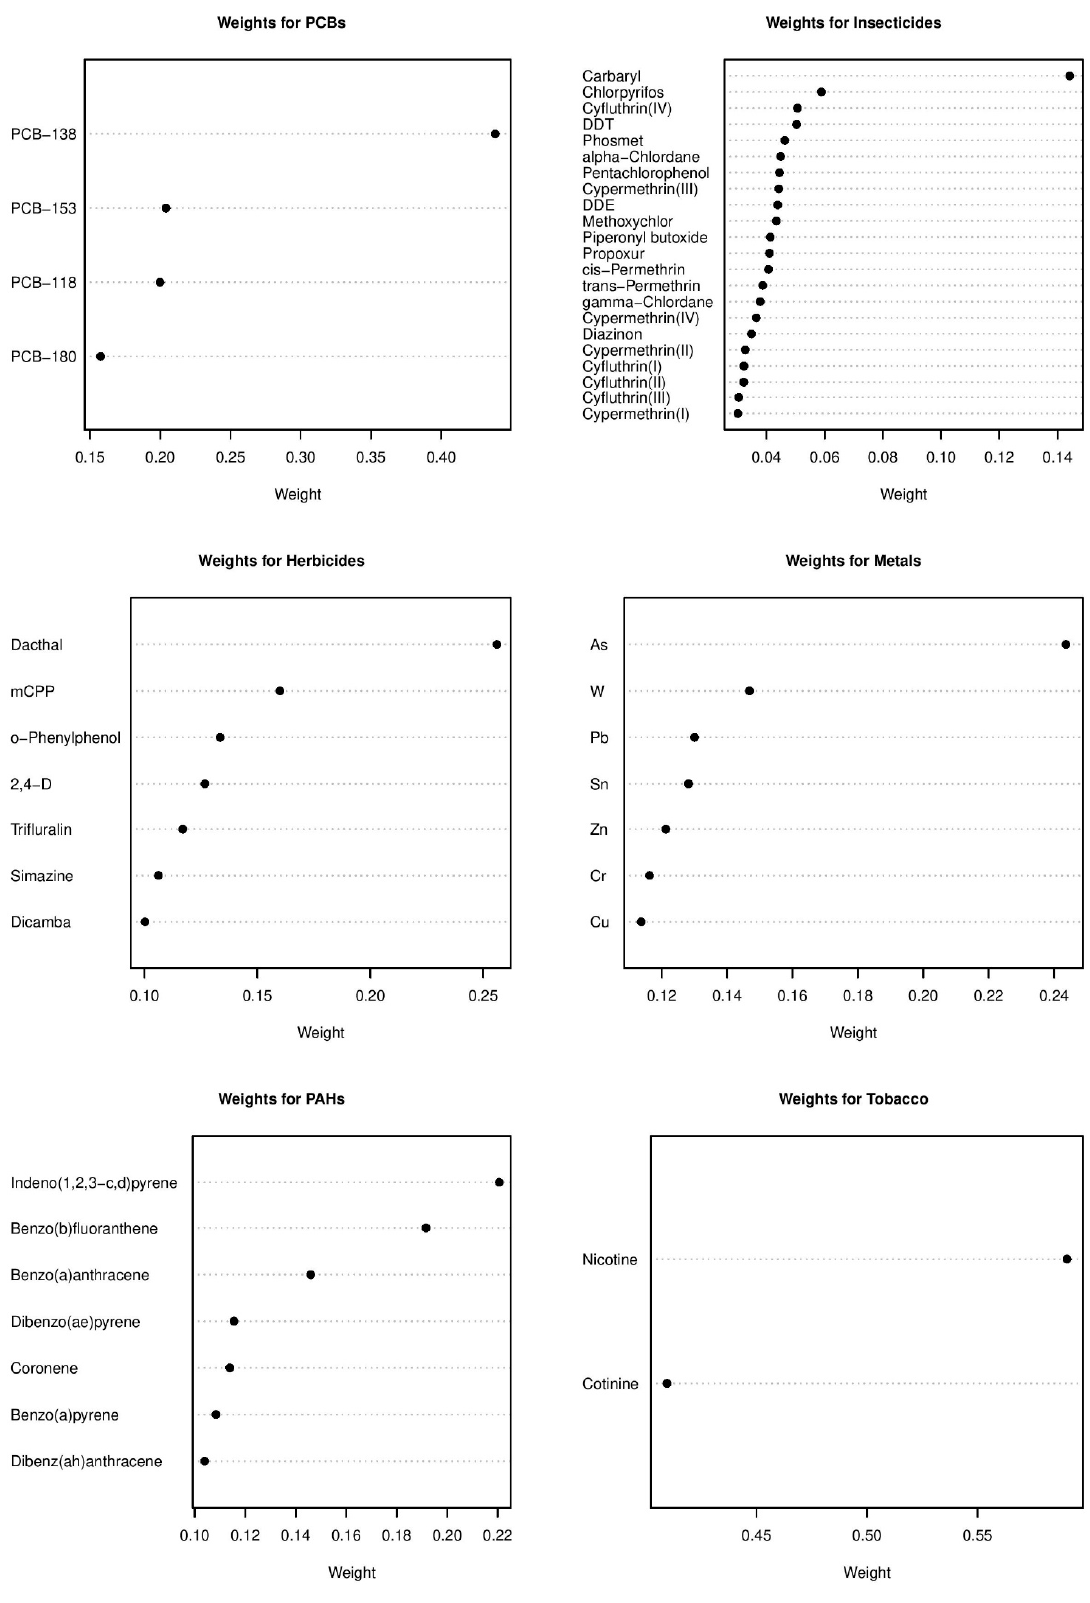
Figure 2. Weights for chemicals in each of the chemical groups from the Bayesian group index model for childhood leukemia in the